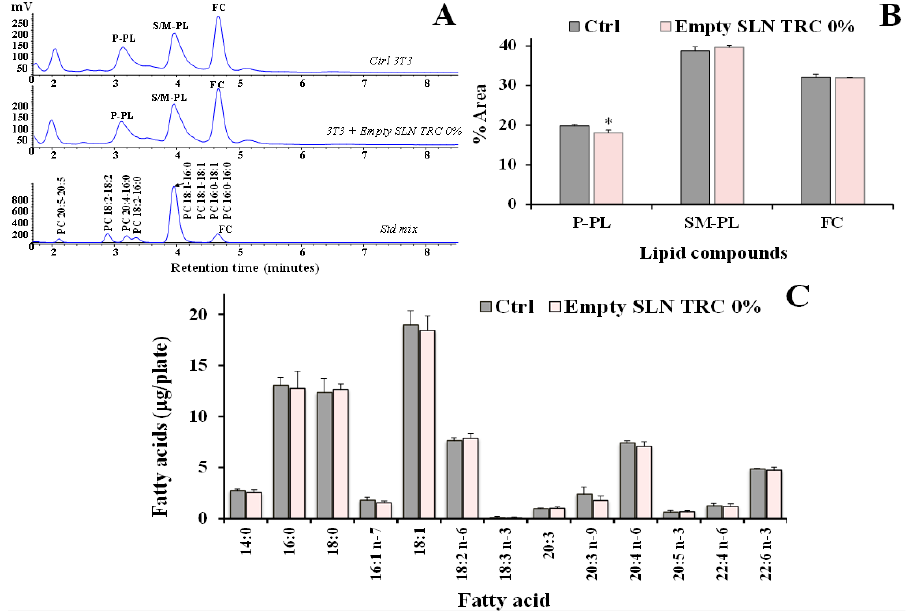
Figure 6. ( A ) Chromatographic profile, obtained by HPLC-ELSD analysis, of lipid compounds (saturated/monounsaturated phospholipids, S/M–PL; polyunsaturated phospholipids, P-PL; free cholesterol, FC) measured in control 3T3 fibroblasts (Ctrl) and cells treated for 24 h with unloaded SLN without TRC (empty SLN TRC 0%) ( A ); the chromatographic region for each lipid class was assigned by using standard mixtures of saturated/monounsaturated (mix PL: PC 16:0/16:0, PC 16:0/18:2, ECN 30, PC 16:0/20:4, PC 18:2/18:2, ECN 28, PC 20:5/20:5, ECN 20). Values of PL and FC (% fatty acids (expressed as µ g / plate) ( C ) measured in control 3T3 and fibroblasts treated with empty SLN area) ( B ) and the main fatty acids (expressed as µg/plate) ( C ) measured in control 3T3 and fibroblasts TRC 0% (24 h). Two independent experiments and tree replicates for each condition are performed and treated with empty SLN TRC 0% (24 h). Two independent experiments and tree replicates for each data are presented as mean ± SD ( n = 6); * = p < 0.05 versus respective Ctrl (Student’s unpaired t test condition are performed and data are presented as mean ± SD ( n = 6); * = p < 0.05 versus respective with Welch’s Ctrl (Student’s unpaired t test with Welch’s correction).